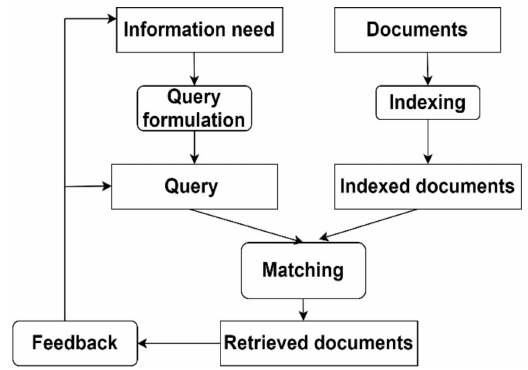
Figure 1. The general structure of the